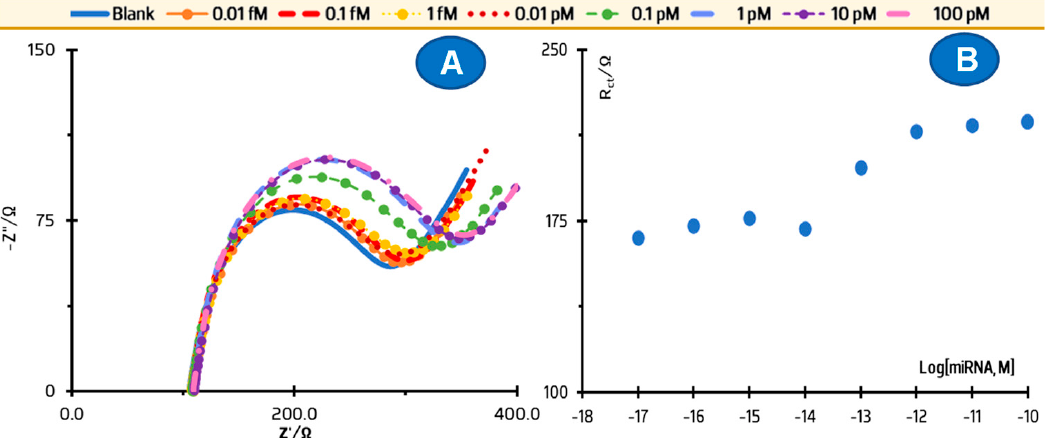
Figure 4. Response of the microRNA 21-5p biosensor against microRNA 26-5p standard solutions. ( A ) Nyquist plots; ( B ) and the corresponding calibration curve.